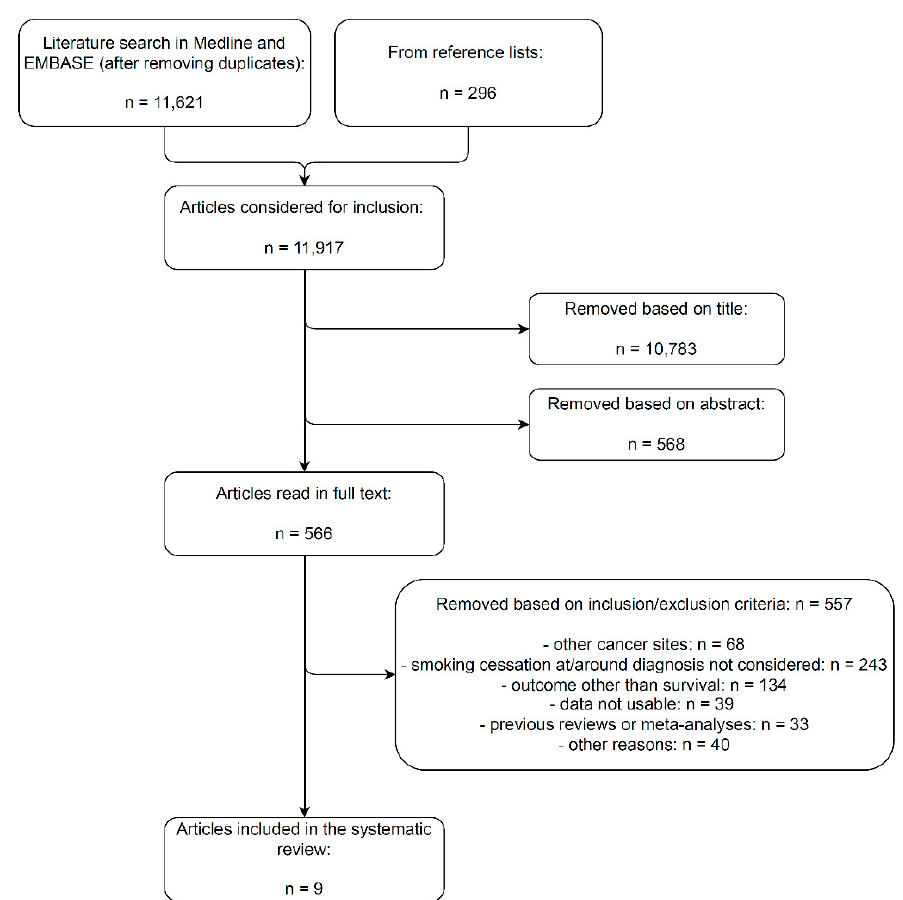
Figure 1. Flow-chart of the literature search and article selection for the systematic review and meta-analysis on the effect of quitting smoking at or around diagnosis on the survival of bladder cancer patients.